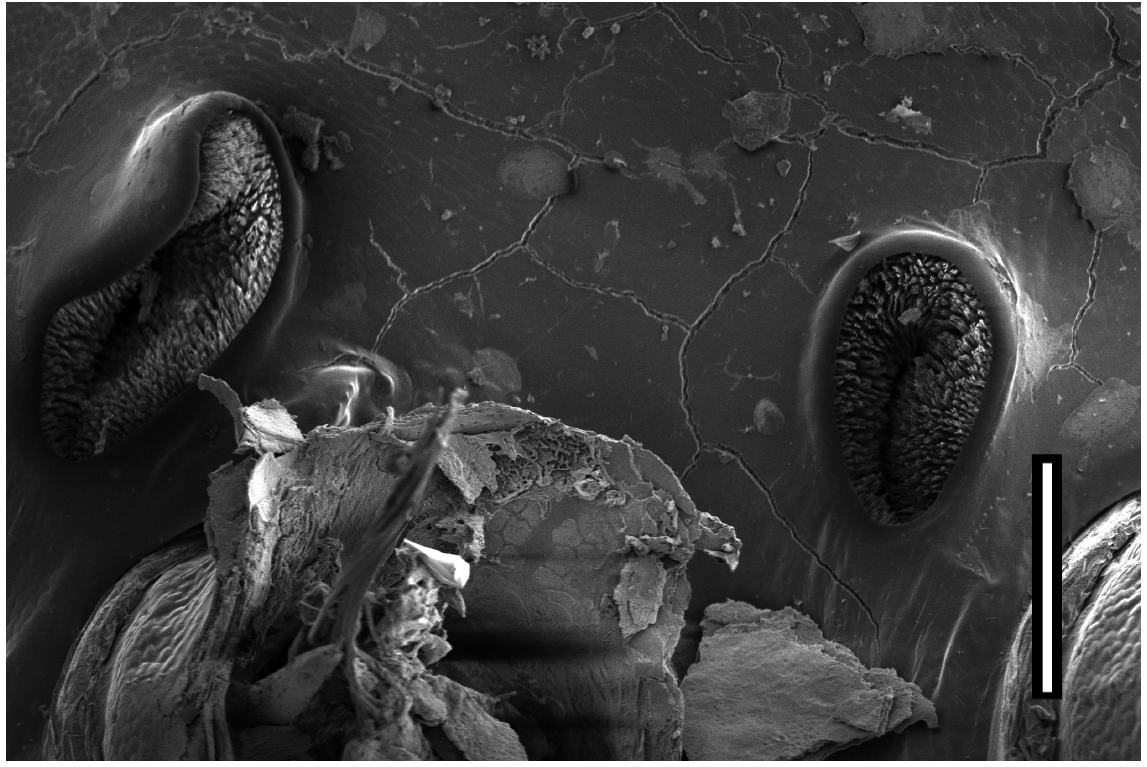
Fig. 17. Pogonosternum laetificum Jeekel, 1982, ♂, spiracles, midbody ring, left lateral side (NMV K-9963). Scale bar: 0.1